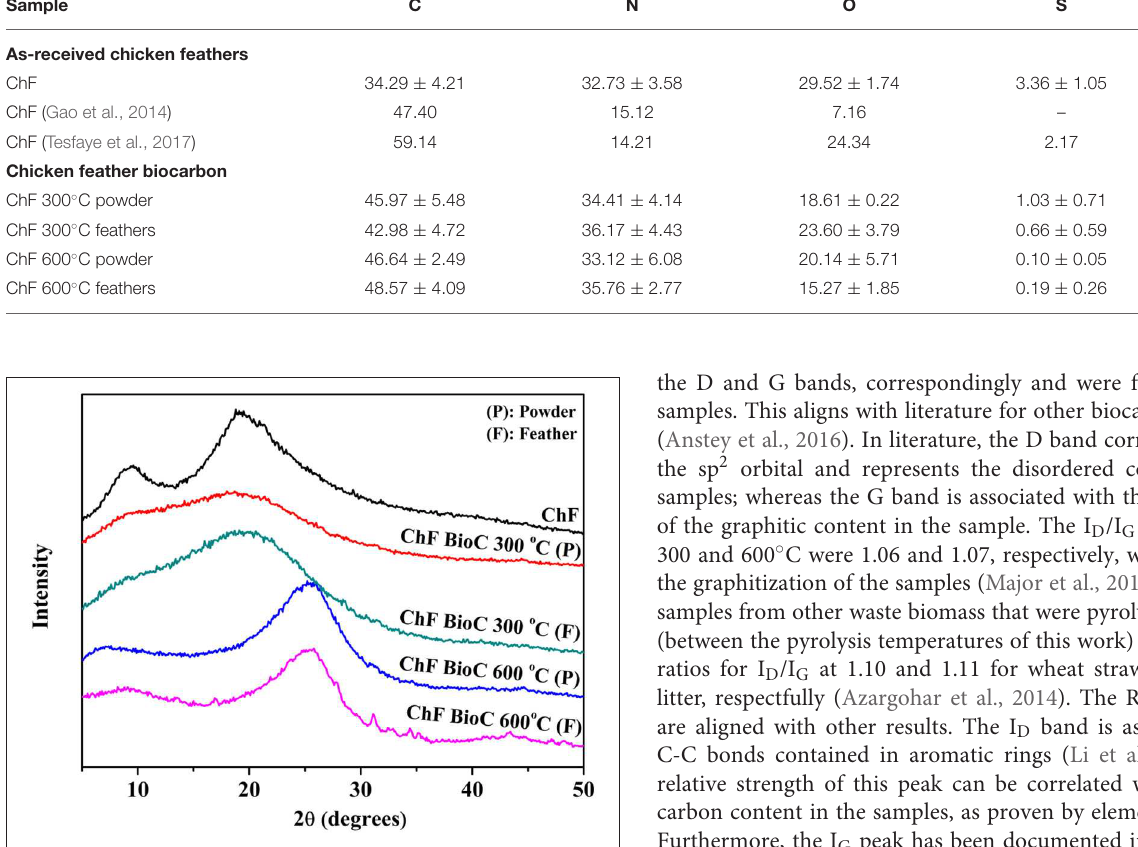
FIGURE 5 | XRD patterns of ChF powder and ChF biocarbon (BioC) at 300 ◦ C and 600 ◦